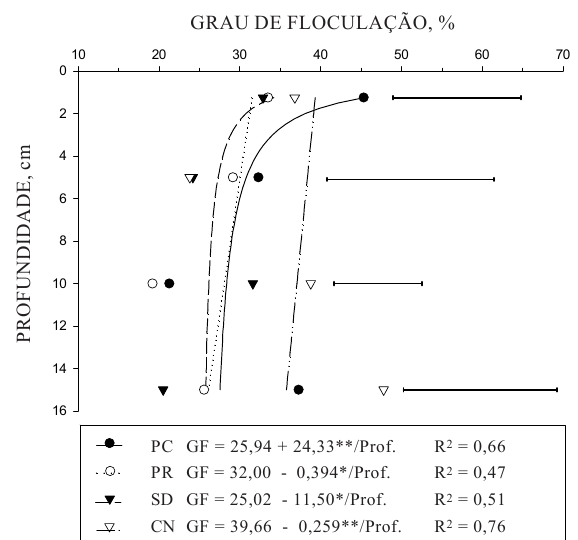
Figura 3. Grau de floculação do solo, em diferentes profundidades, sob diferentes sistemas de ma- nejo. Os pontos representam as médias dos tra- tamentos (n = 3). As barras horizontais indi- cam diferenças mínimas significativas entre tratamentos em uma mesma profundidade, cal- culadas pelo teste de Duncan a 5 %. * e **: signi- ficativos a 10 e 1